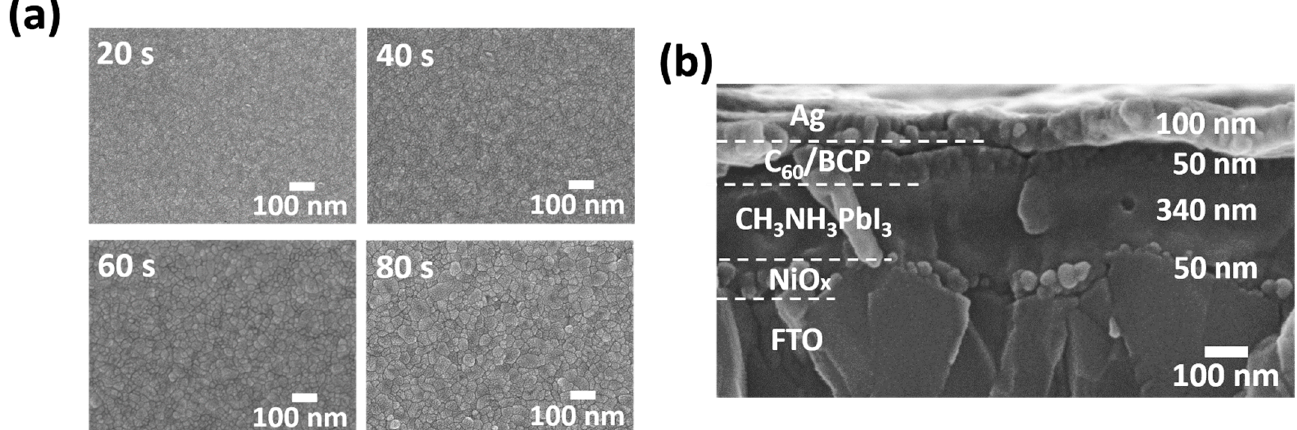
Figure 4. SEM images show surface morphology of various NiO x films on FTO substrate: ( a ) from top-view: disposition time: 20 s, 40 s, 60 s, and 80 s, respectively. These samples were annealed at 500 °C for 1 h; ( b ) cross-sectional view of a perovskite solar cell device with stacking sequence of FTO/NiO x /CH 3 NH 3 PbI 3 /C 60 /Bathocuproine (BCP)/Ag (both scale bars are 100 nm). The HRTEM magnified image of NiO x (deposit = 40 s) and CH 3 NH 3 PbI 3 film are